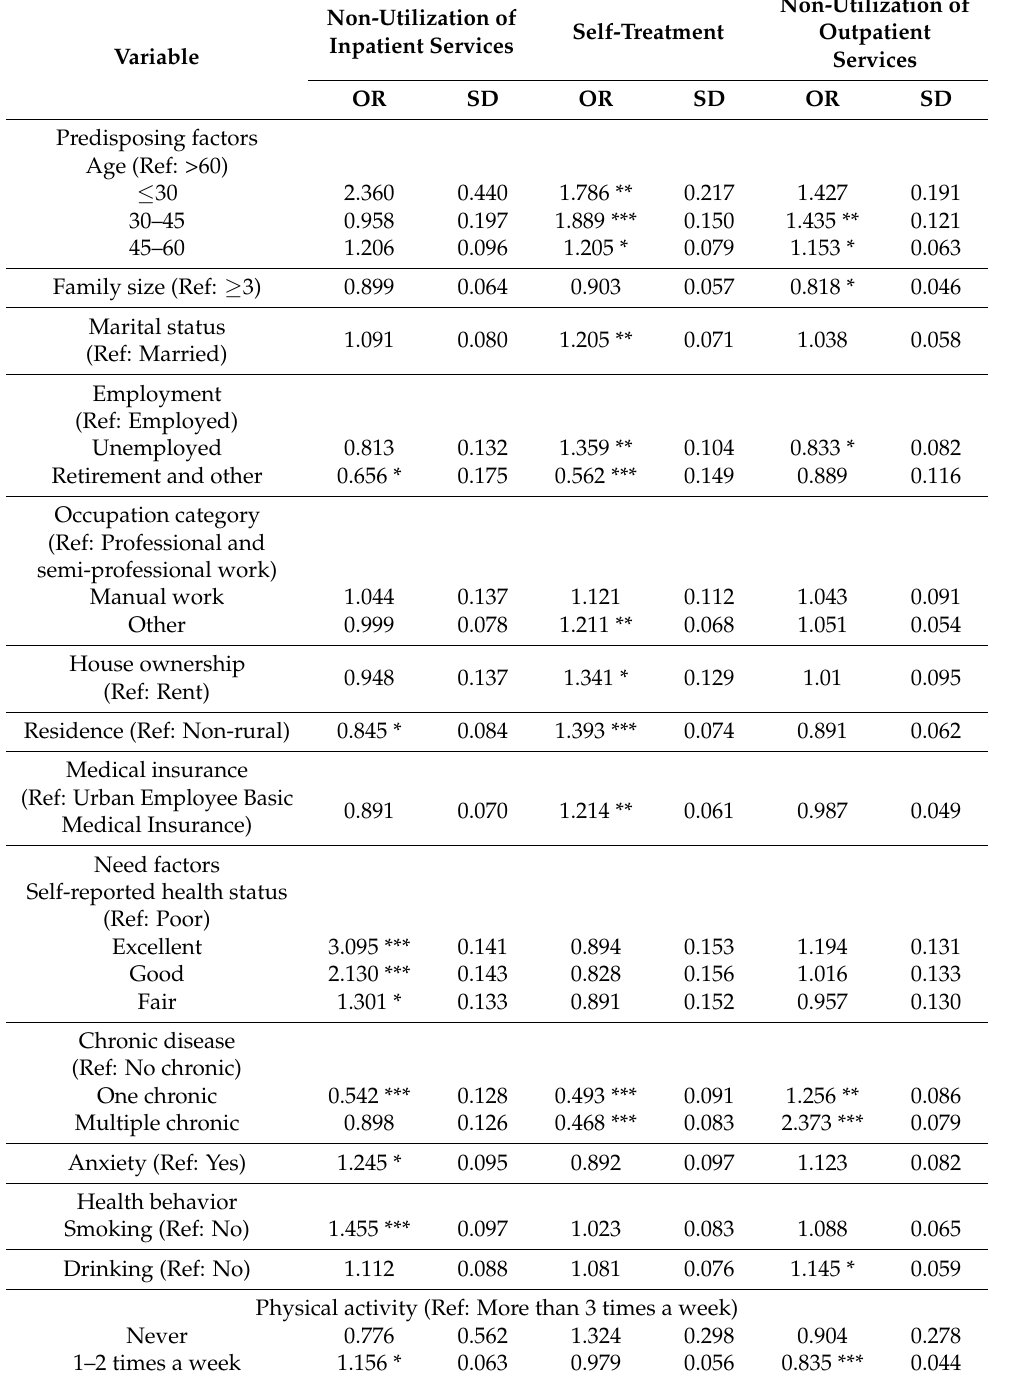
Table 5. Logistic regression of unmet healthcare needs among unwell non-migrants in Shanghai. Non-Utilization of Non-Utilization of Self-Treatment Outpatient Inpatient Services Variable